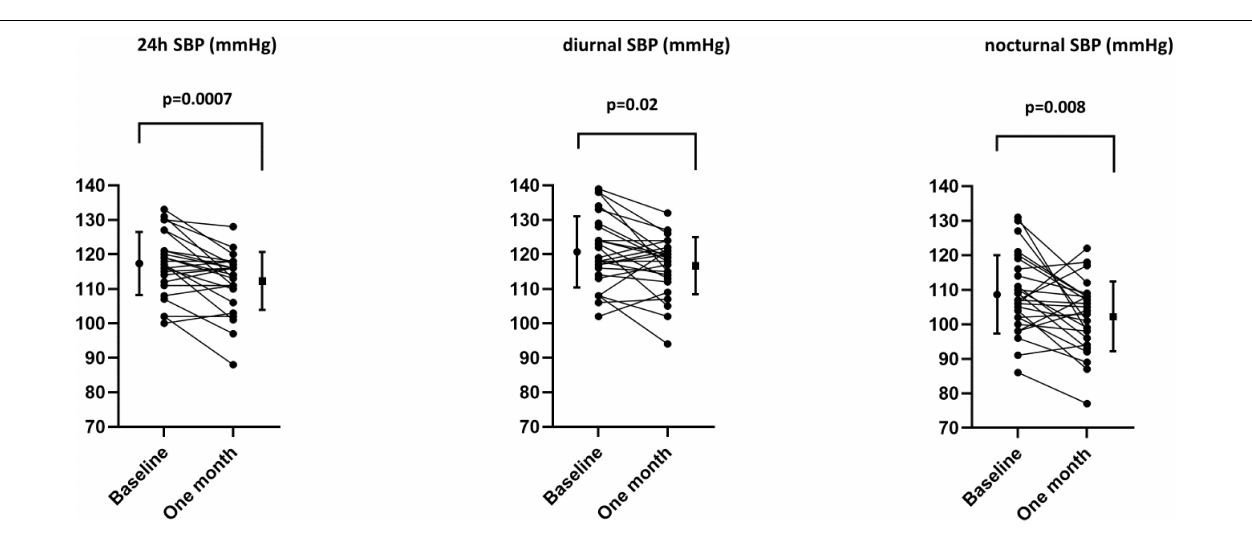
significantly with changes in plasma PRA levels (adj Rsq 0.22; p =